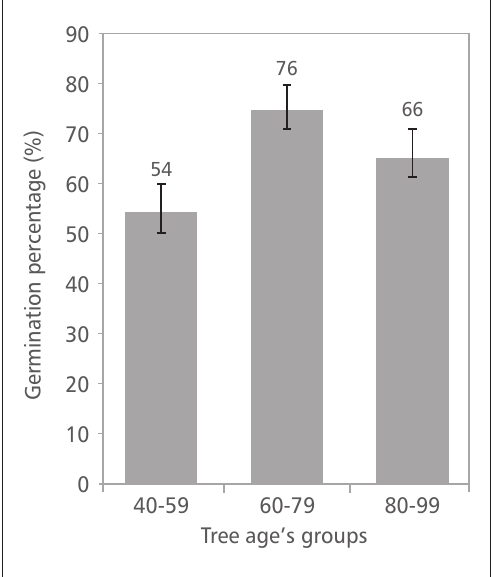
FIGURE 3. The effects of tree age’s factor on germination percentage